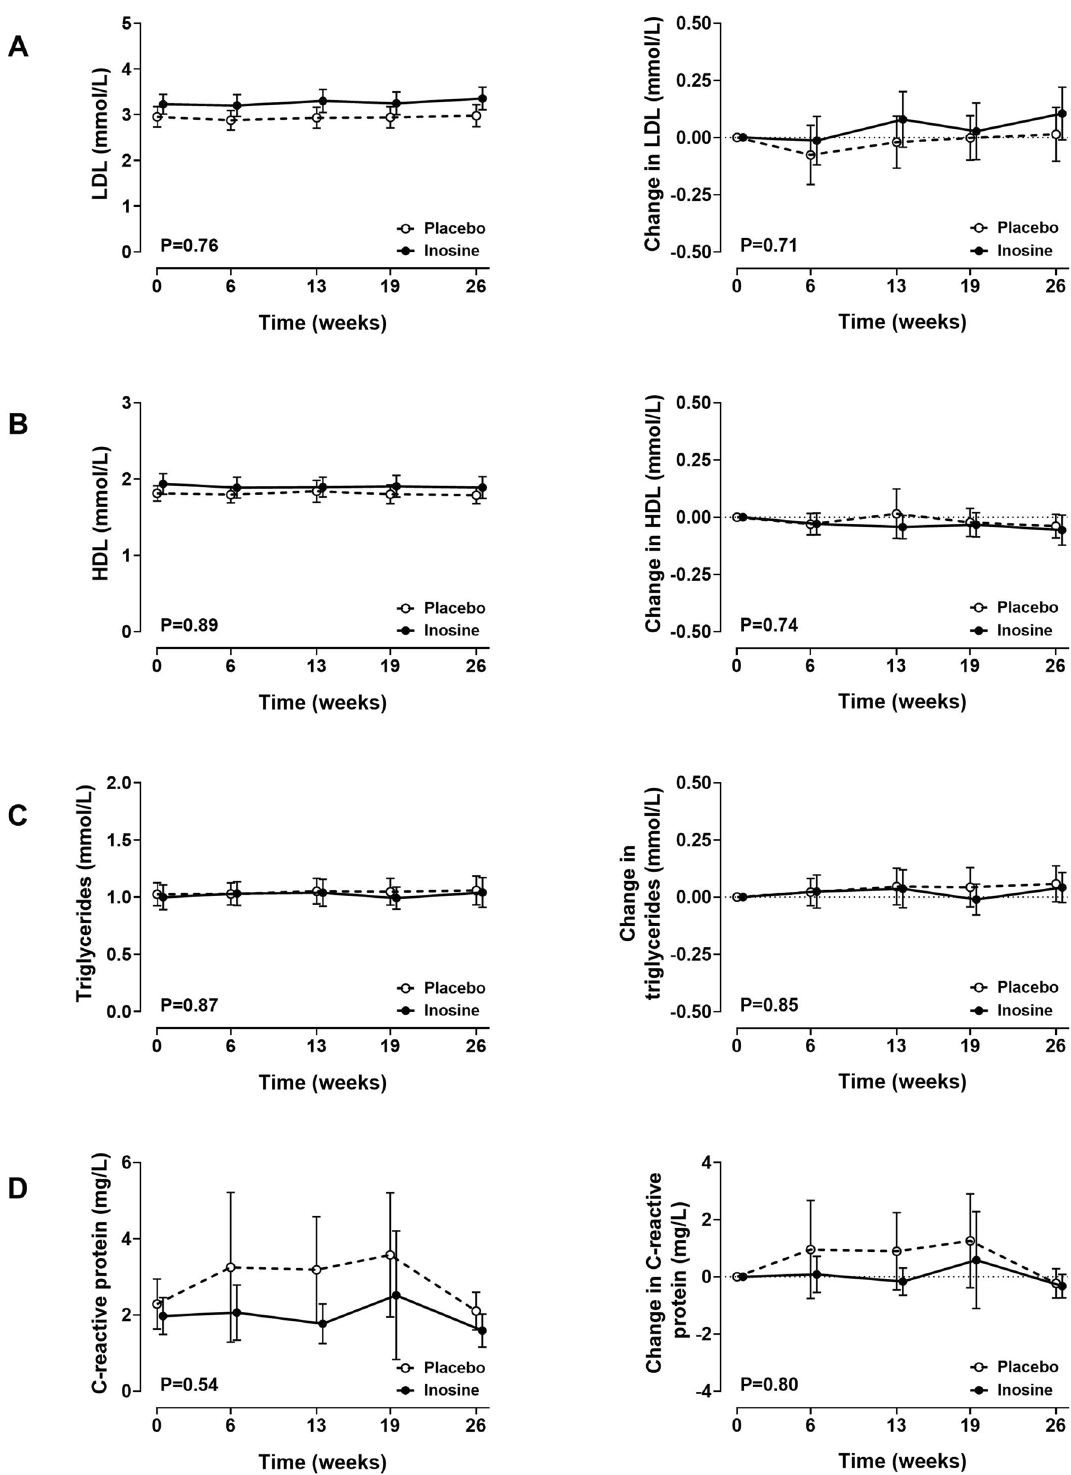
Figure 3. Lipid profile and C-reactive protein. Absolute values (left panel) and change from baseline (right panel). ( A ) LDL cholesterol; ( B ) HDL cholesterol; ( C ) triglycerides; ( D ) C-reactive protein. Data are shown as mean (95% CI), with P time×treatment